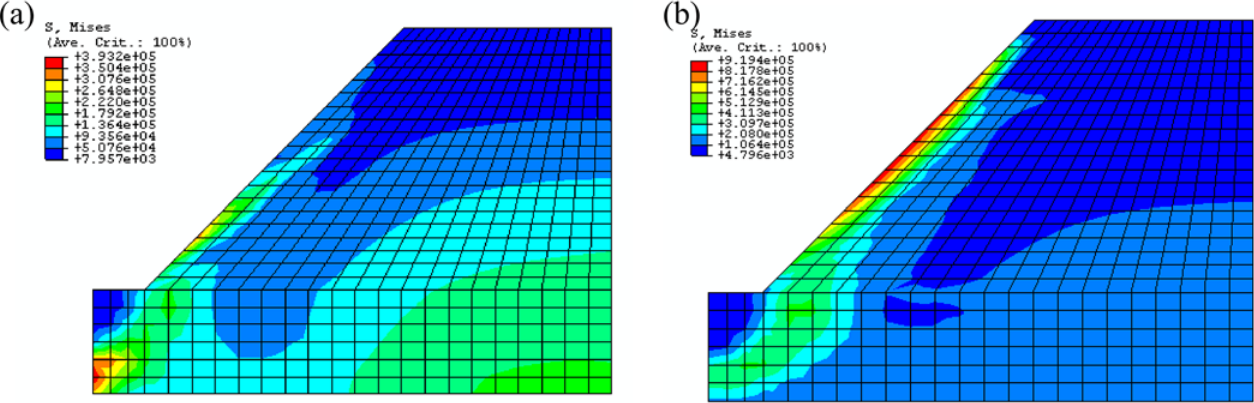
Fig 22. The Mises stress contour calculated by proposed constitutive model for the different slopes((a) The Mises stress contour calculated by proposed constitutive model for the first slope; (b) The Mises stress contour calculated by proposed constitutive model for the second slope)